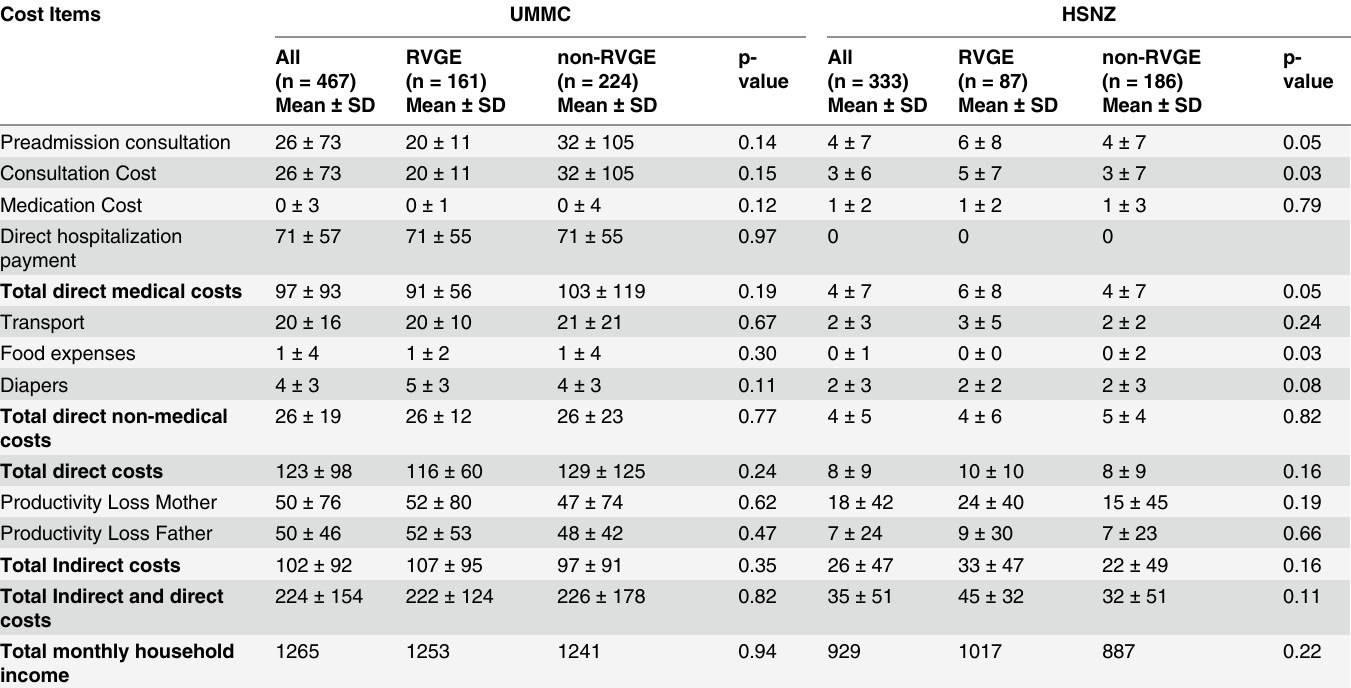
Table 2. Costs incurred by households when children are hospitalized for acute gastroenteritis and tested for rotavirus at UMMC, Kuala Lumpur and HSNZ, Kuala